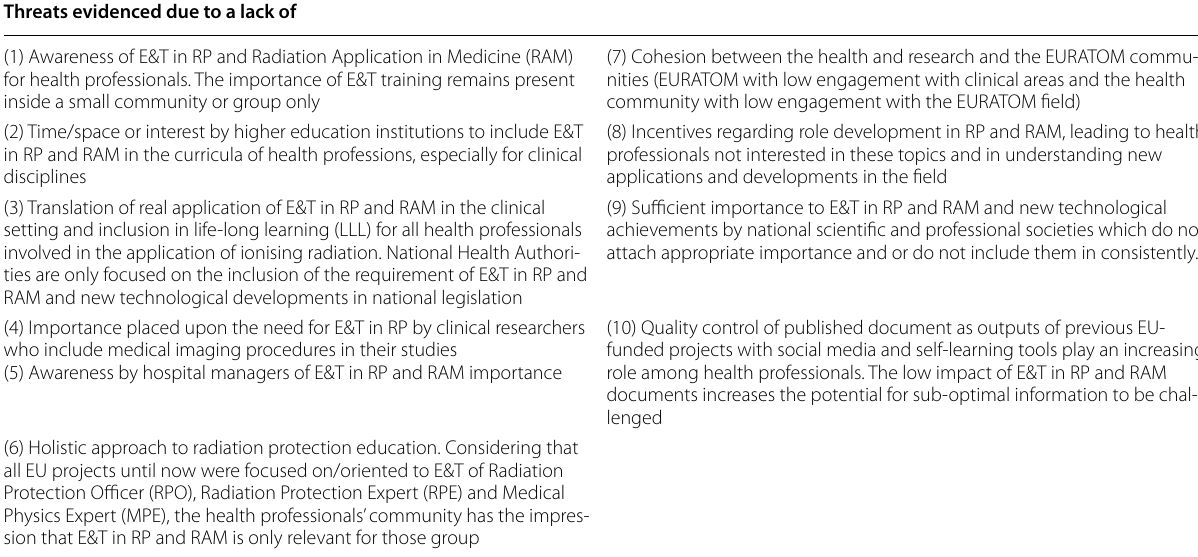
Table 2 Summary of the threats evidenced during SWOT analysis Threats evidenced due to a lack